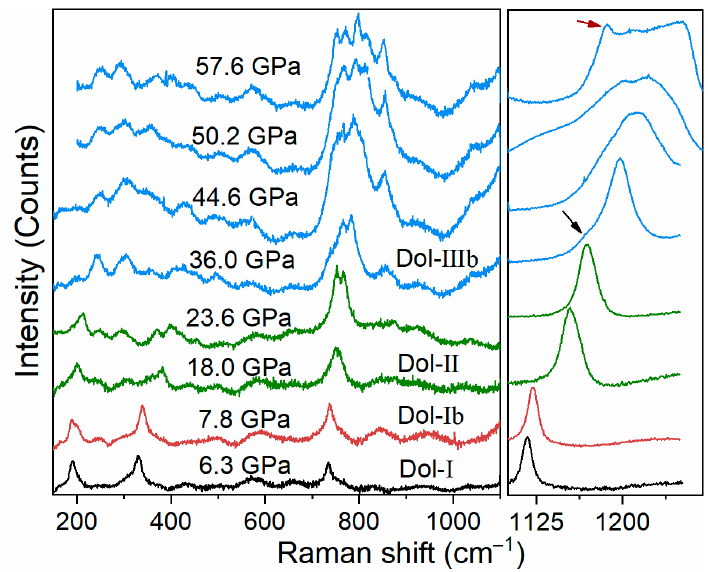
Figure 6. Representative Raman spectra of iron-bearing dolomite with increasing pressure. The Dol-Ib, Dol- Ⅱ , and Dol- Ⅲ b phases occur at around 7.8, 14.8 and 36.0 GPa, respectively. The new peak observed at 36.0 GPa (shown as the black arrow) represents the onset of Dol- Ⅲ b phase. Meanwhile, one of the ν 1 modes shifts to a lower frequency of ~1186 cm − 1 at 57.6 GPa (shown as the red arrow), which may be related to the 3 + 1 coordination in Dol- Ⅲ b [29]